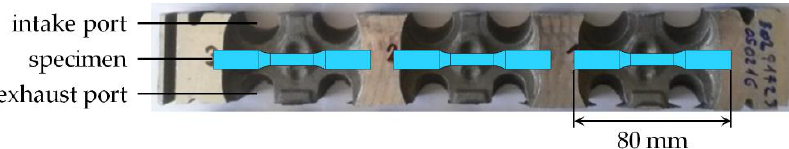
Figure 1. Specimen extraction.